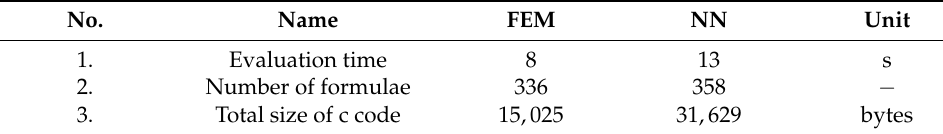
Table 5. AceGen—FEM vs. NN.